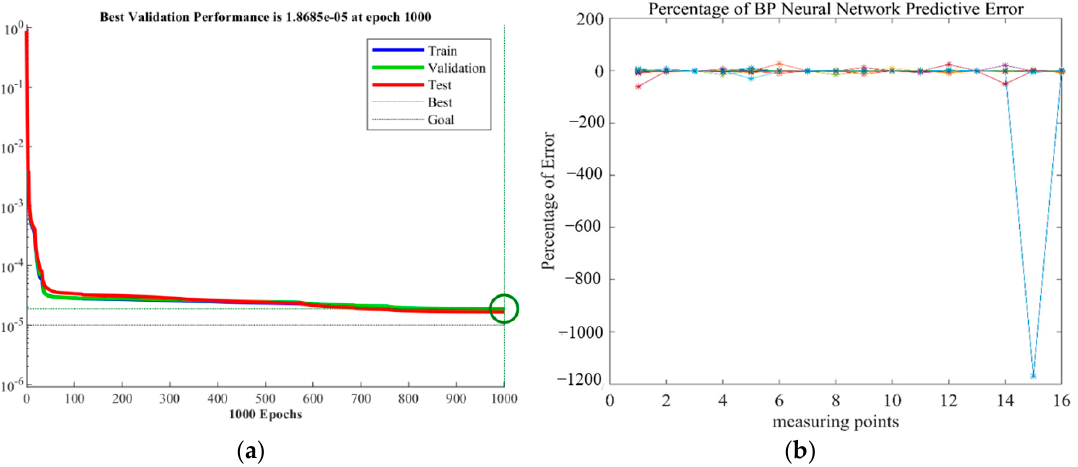
Figure 8. Model training process: ( a ) Relationships between the MSE of neural network and epochs; ( b ) Percentage of prediction error of measurement points.